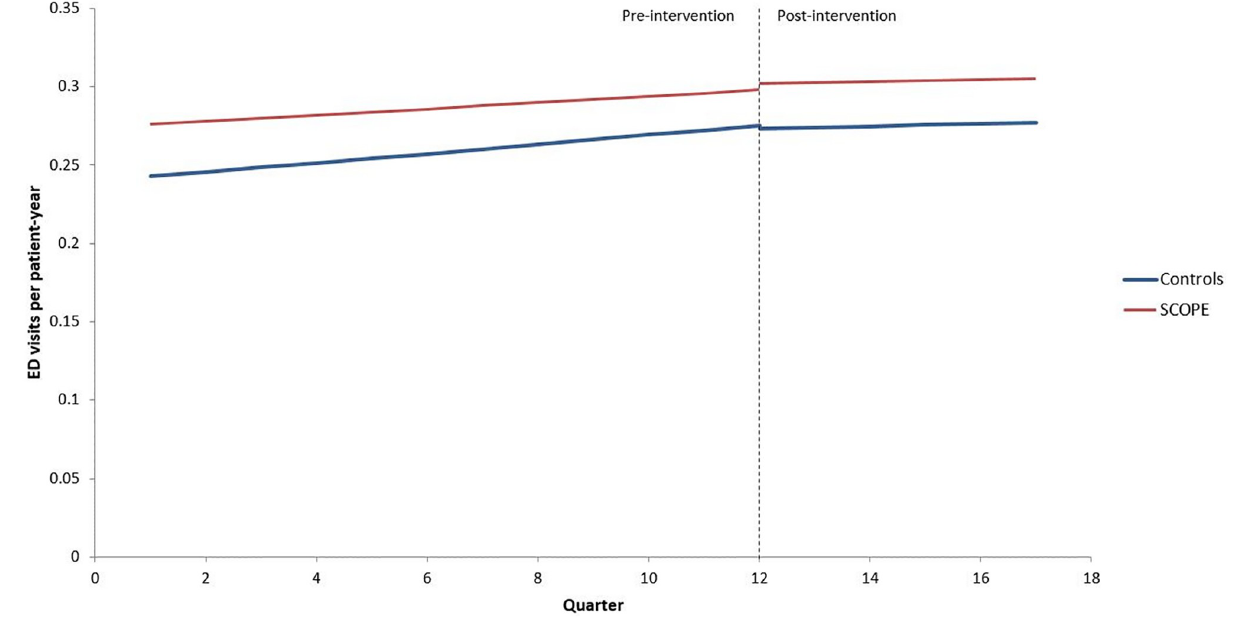
Fig 2. ED visit rates quarterly from 3 years pre- to 18 months post-intervention (Oct 1, 2009 –Mar 31, 2014).